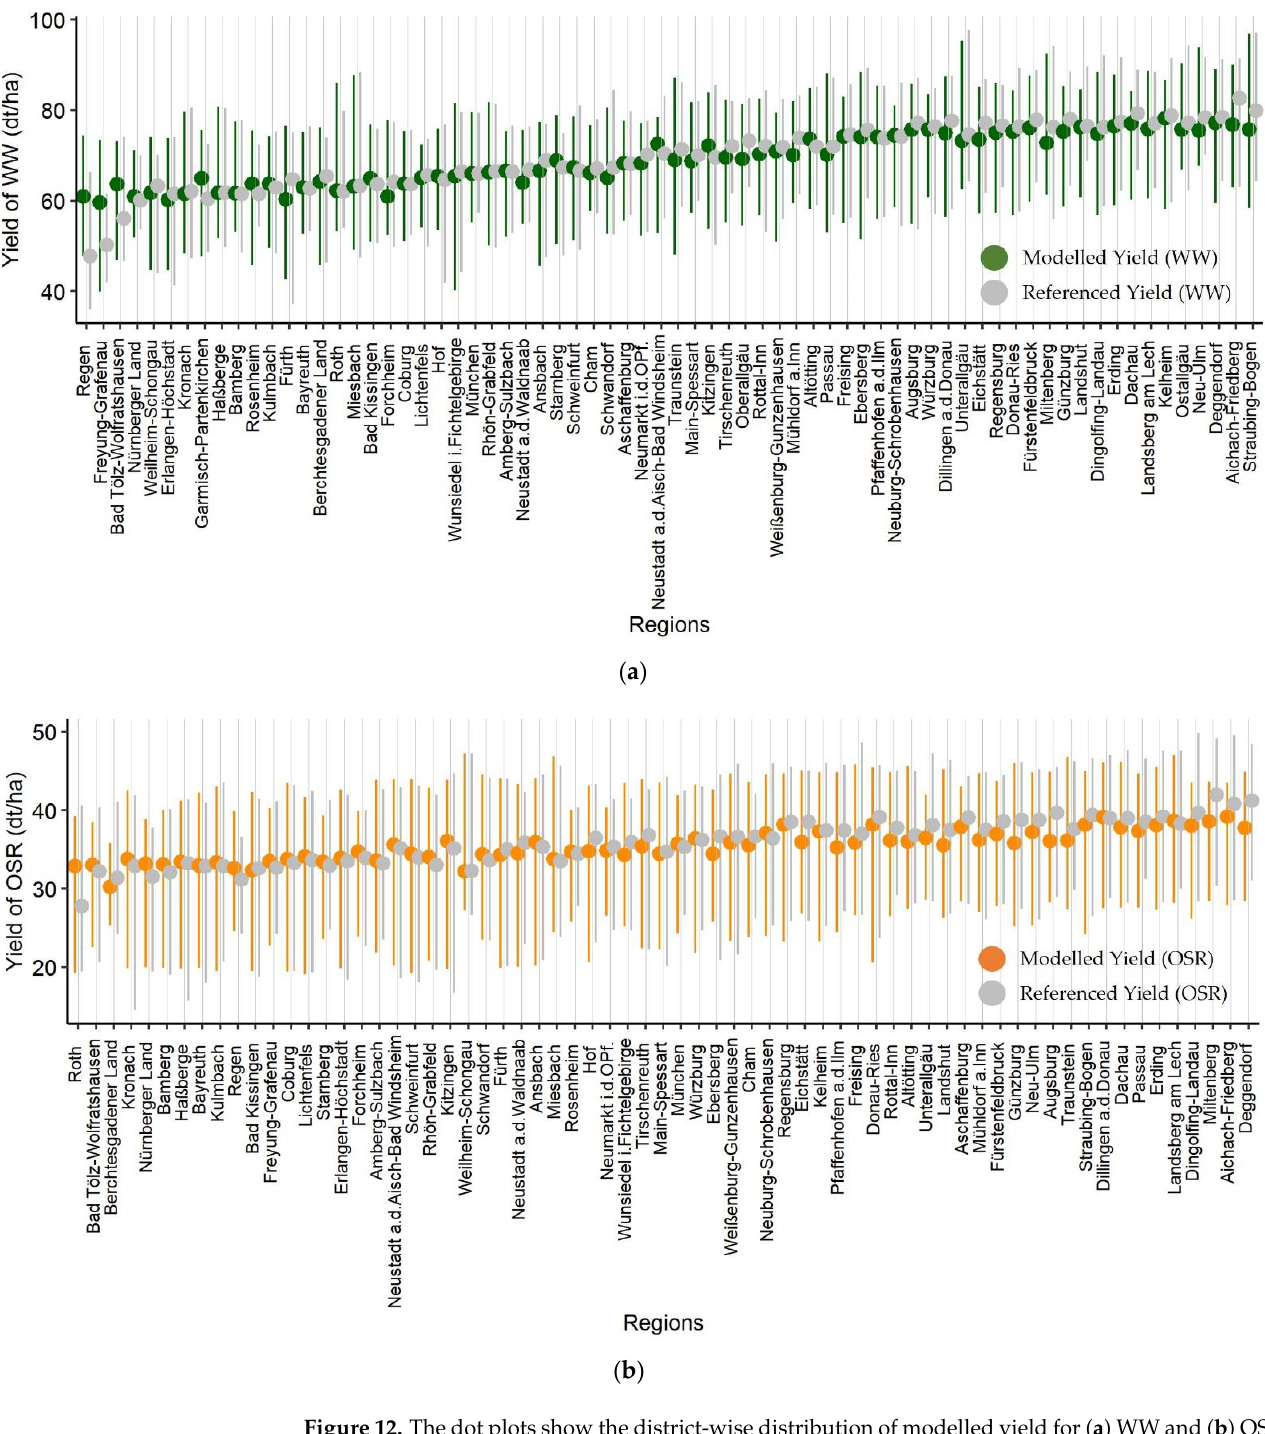
Figure 13. The line plots compare the accuracies with the mean yield percent difference (as calcu- lated in Equation (9)) for WW and OSR for 19 years (i.e., from 2001 to 2019). The accuracies of WW and OSR are analysed in six categories (less than −4 , −4 to −2 , −2 to 0, 0 to 2, 2 to 4, and more than 4%) of yield percent difference. The negative range shows the overestimation, and the positive range shows the underestimation of the modelled yield values by the LUE compared to the refer- enced yield values. The green colour depicts WW, and the orange colour depicts OSR. 3.6. Correlation Analysis between the Accuracy Assessments of the Input Synthetic Products and the Crop Yield Modelling The bar and scatter plots compared and linked the yearly accuracies of the input synthetic time series with the crop yield modelling for WW and OSR from 2001 to 2019, respectively (Figures 14 and 15). For WW, the correlation coefficient showed a higher positive correlation of 0.81 between the R 2 of synthetic accuracy and the modelled yield